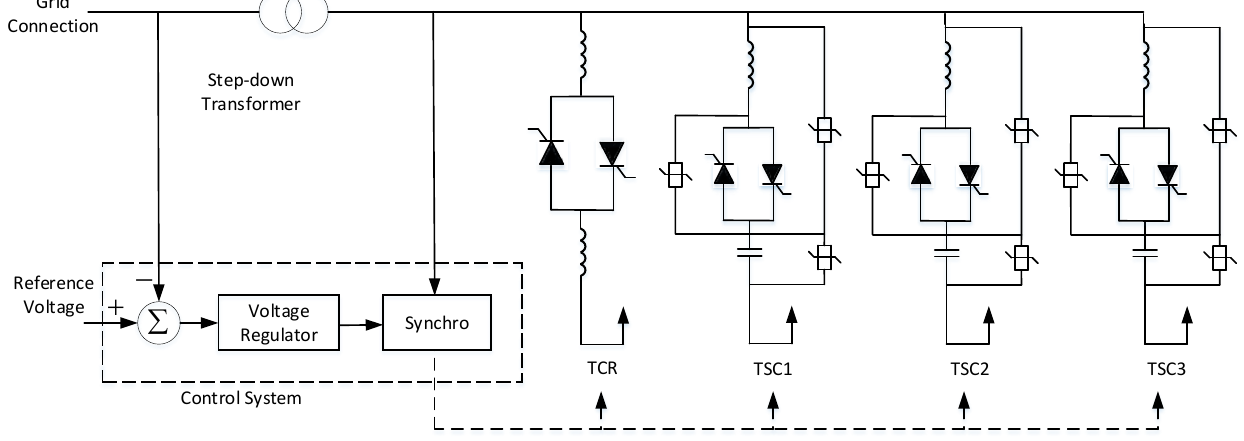
Figure 5. Block diagram representation of the static var